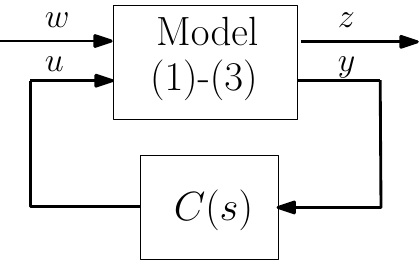
Figure 4. H ∞ standard